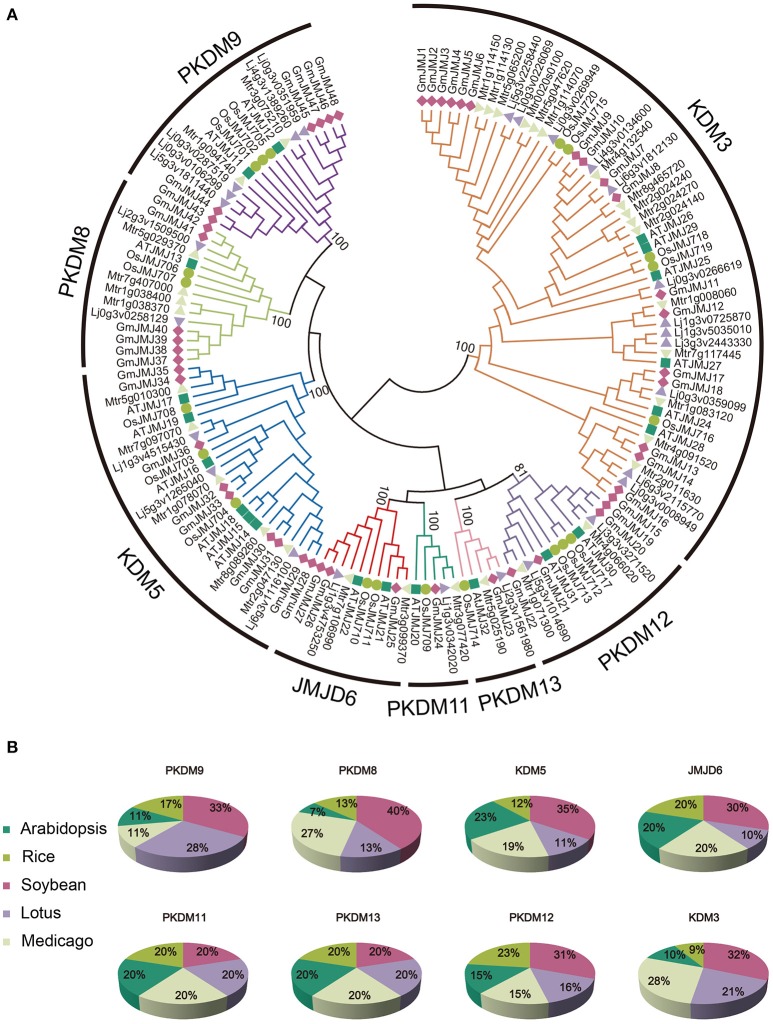
Phylogenetic relationship and distribution of JmjC-domain containing proteins from five plant species. (A) Phylogenetic relationship of JmjC-domain containing proteins among soybean, Medicago, Lotus, rice, and Arabidopsis. Both multiple sequences alignment and phylogenetic tree were performed by MEGA6.0. The value at the nodes represents bootstrap values from 1000 replicates. Different groups were shown by different color. (B) Percentage representation of JmjC-domain containing proteins across the five plant species within each group. Colors correspond to the plant taxa as listed in the left.